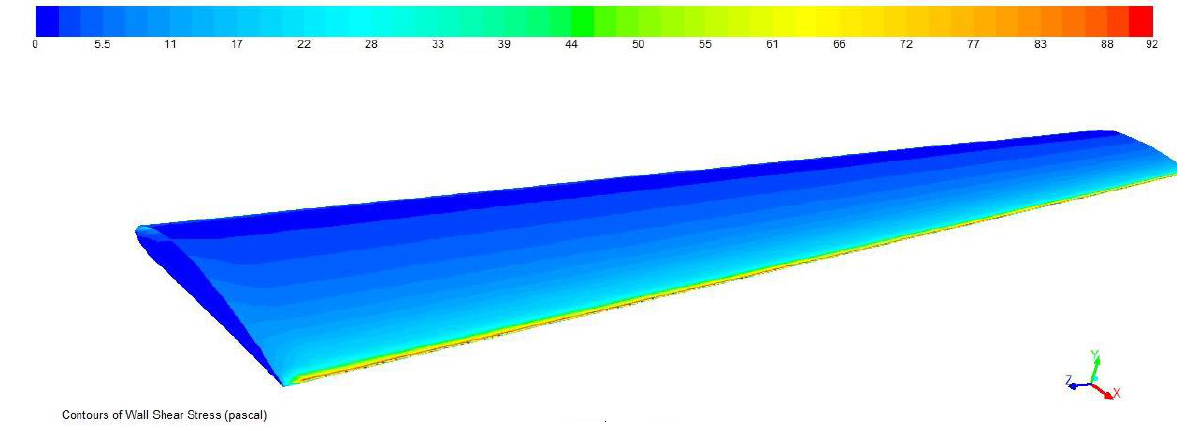
Figure 7: Shear stress on wind turbine blade surface of glass fibre-resin for 65 ms −1 wind velocity and sand injection from 9 0°